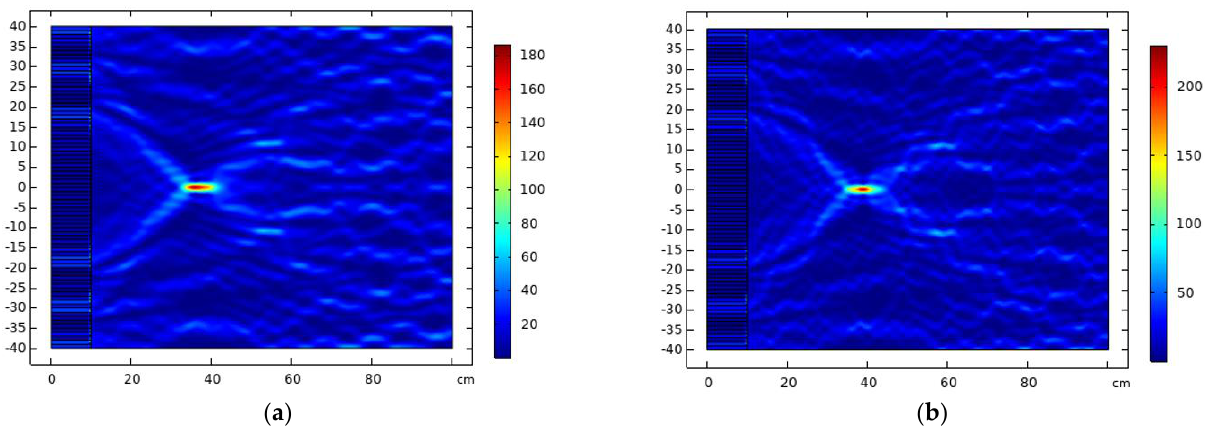
Figure 10. Spatial distributions of acoustic intensity field through focusing lens at ( a ) 28 kHz and ( b ) 35 kHz.